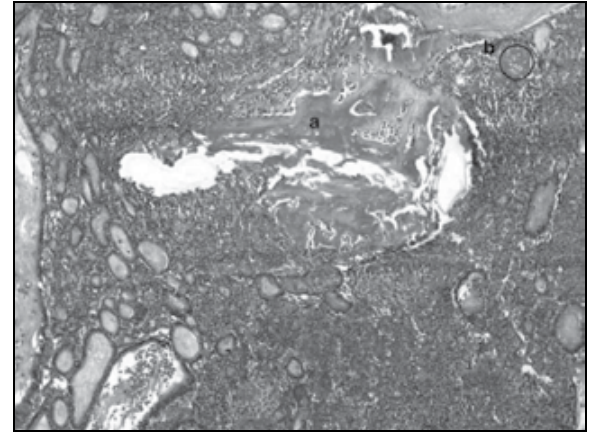
Figura 3 – Aspecto histopatológico (a) material mineralizado sugestivo de material dentinoico; (b) células fantasmas (HE, 100×). HE: hematoxilina e